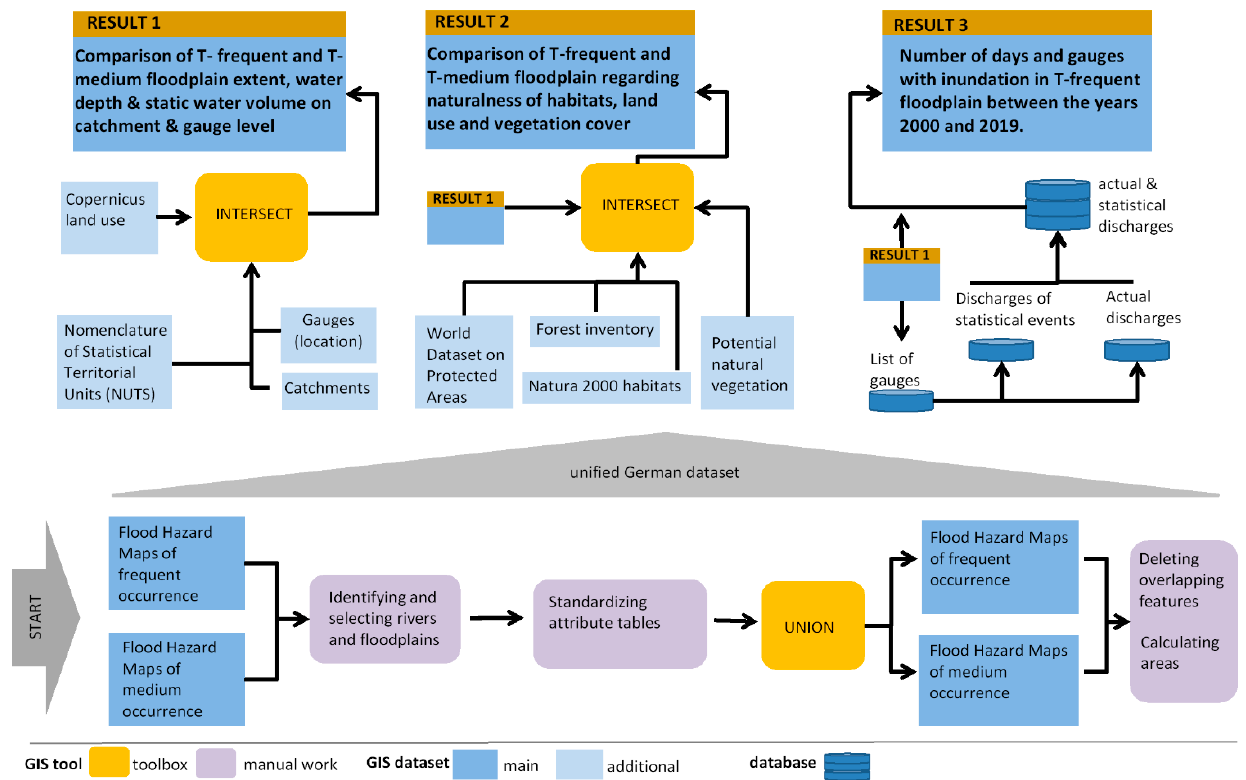
Figure 3. Schematic data processing of flood hazard maps for T-frequent (T5–T25) and T-medium (T100) floods. Table 2. Characteristics of flood hazard maps (FHM) applied in this study, collected from federal